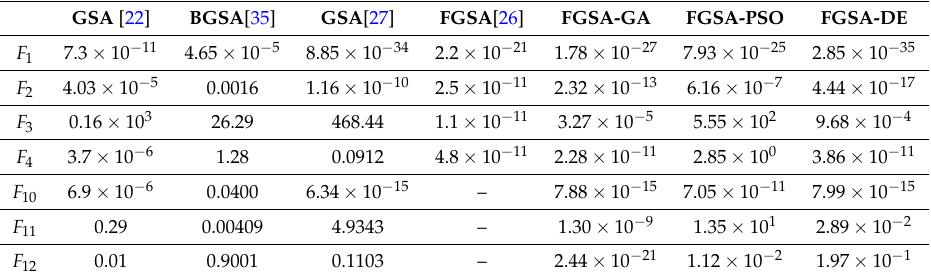
Table 7. Comparison between FGSA-GA and revised GSA over 30 runs.